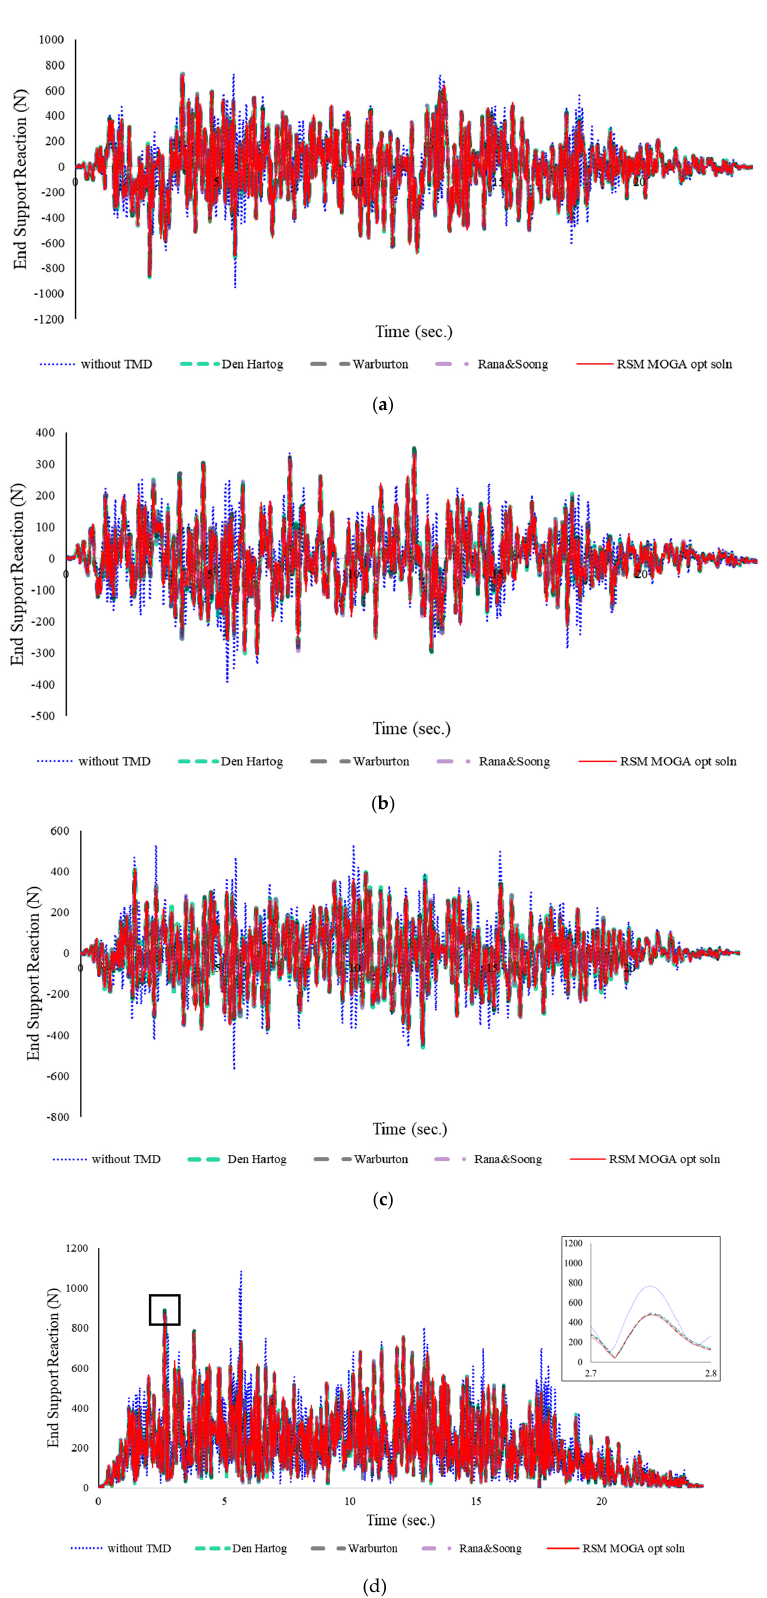
Figure 11. Comparison of the reaction forces at the lowest support of the piping system: ( a ) X direction; ( b ) Y direction; ( c ) Z direction; ( d ) total.